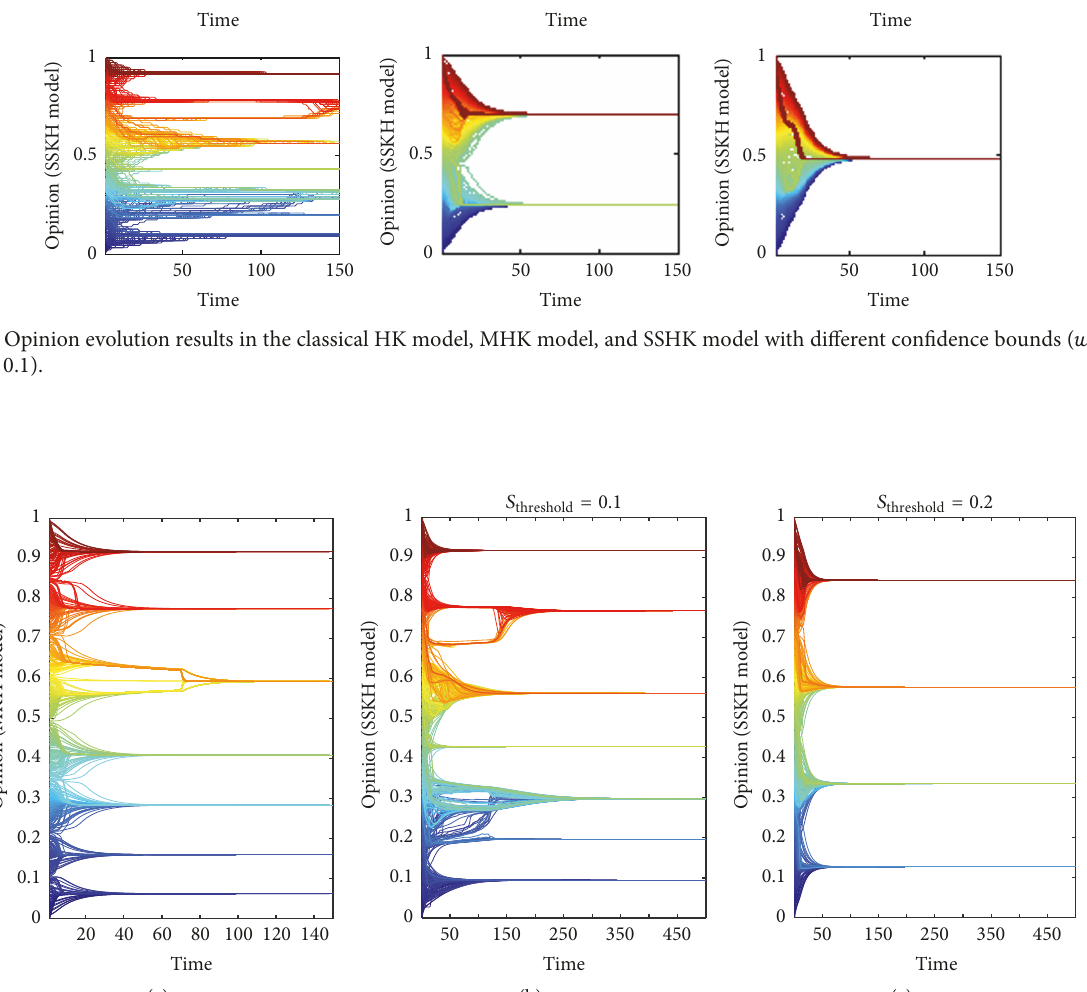
Figure 5: Comparison of opinion evolution results in the MHK model and SSHK model ( 𝑤 𝑠 = 0.3 , 𝑠